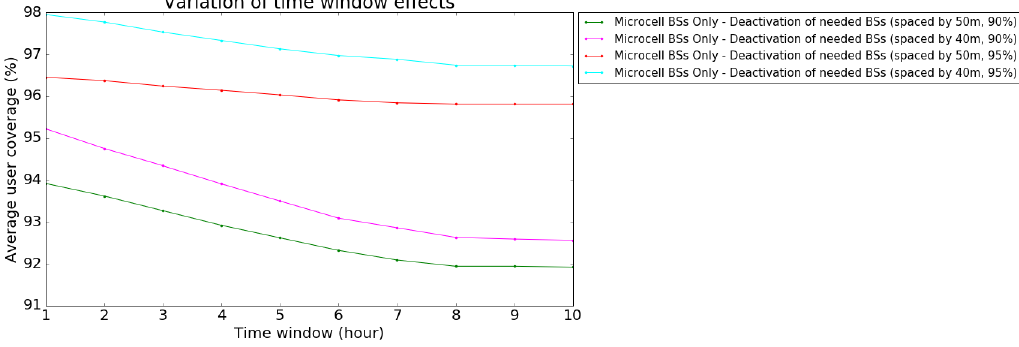
Figure 17. Only Microcell BSs: Deactivation of some BSs . Effects of the time window on the user